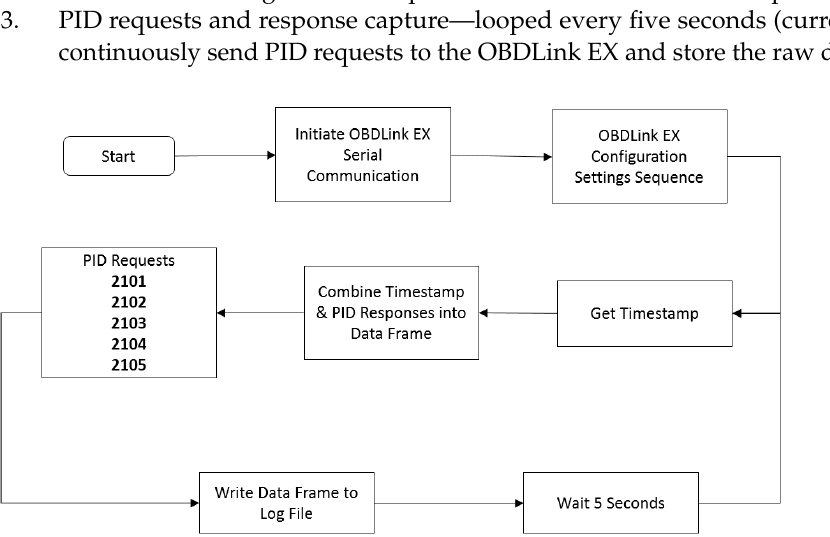
Figure 7. Flowchart showing the method developed for capturing and logging OBD-II data from the